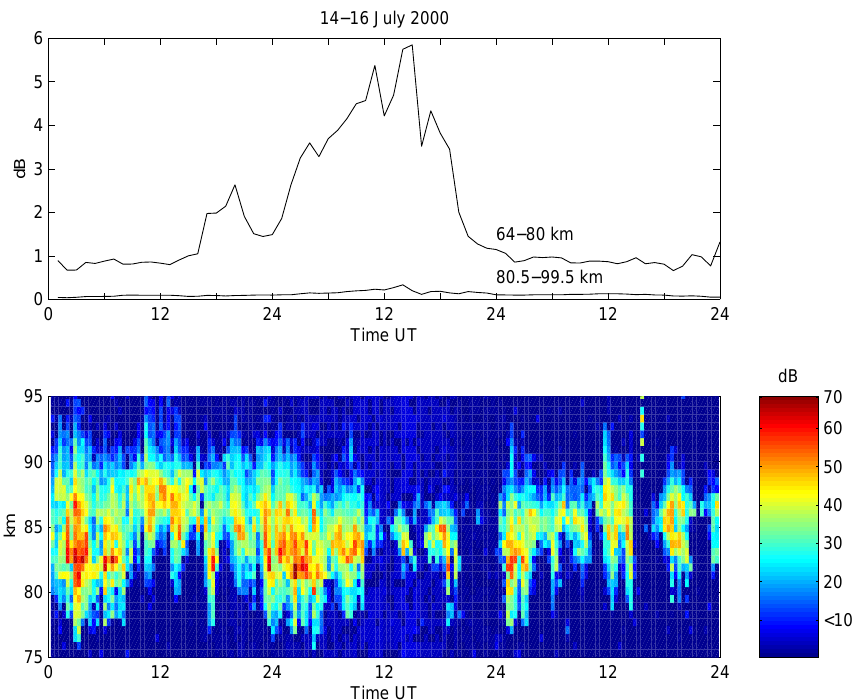
Fig. 3. Top panel: Height integrated absorption of the radar signal at 52MHz. Bottom panel: Corrected ESRAD echo power. Yagis with a 0 . 7 λ spacing. The radar was operated in two modes. For the altitude range of 80–90 km data were col- lected using a 16-bit complementary code with a 150 m range resolution. The sampling frequency was set to 1450 Hz. For the altitude range of 4.8–99.6 km a 8-bit complementary code with a 600-m range resolution was used. The sampling fre- quency for that mode was set to 1300